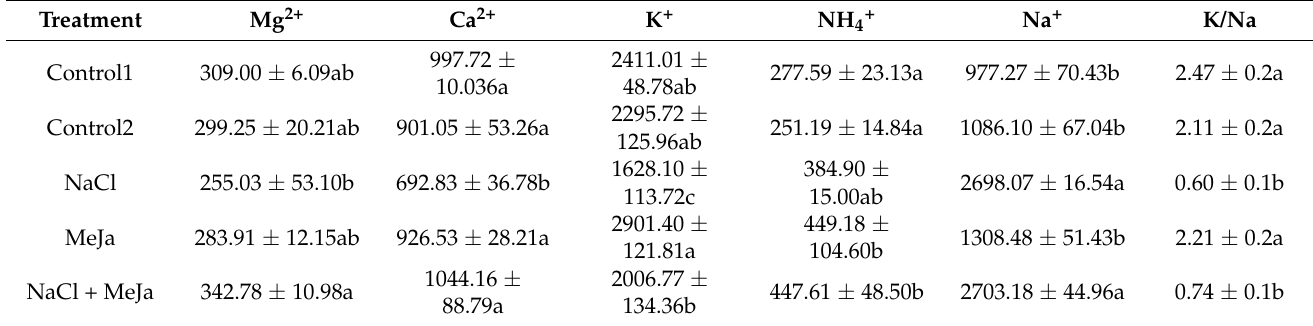
Table 2. The content of cations (Mg 2+ , Ca 2+ , K + , NH 4+ , Na + and K/Na ratio) (mg kg − 1 FW) in the leaf tissues of C. maritimum under the different treatments (Control1, Control2, NaCl, MeJa, NaCl + MeJa), ( n = 10). Columns with different letters (a, b, c) for each variable differ significantly according to Tukey’s test ( p < 0.05). Treatment